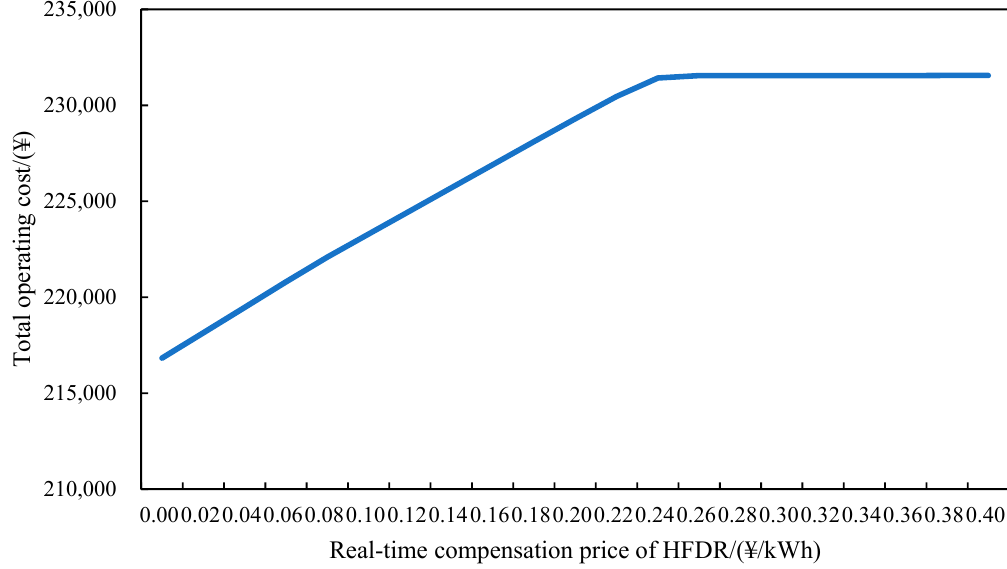
Figure 12. Sensitivity analysis of the real-time compensation price of thermal load.